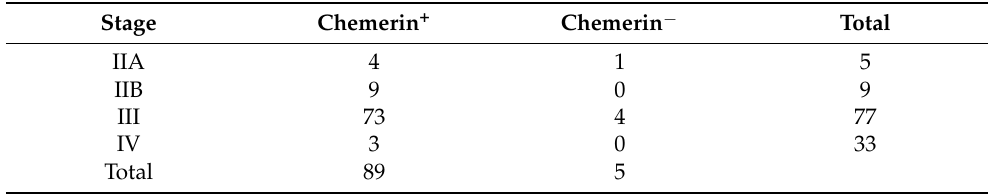
(Table 2), gender (Table 3) or age of the patients (Table 4). Additional information on the patient population is shown in Supplementary Table S1. Table 2. Patients and chemerin status by cancer stage. p = 0.421 by Chi-squared test. Evaluated were only patients with readable cores.